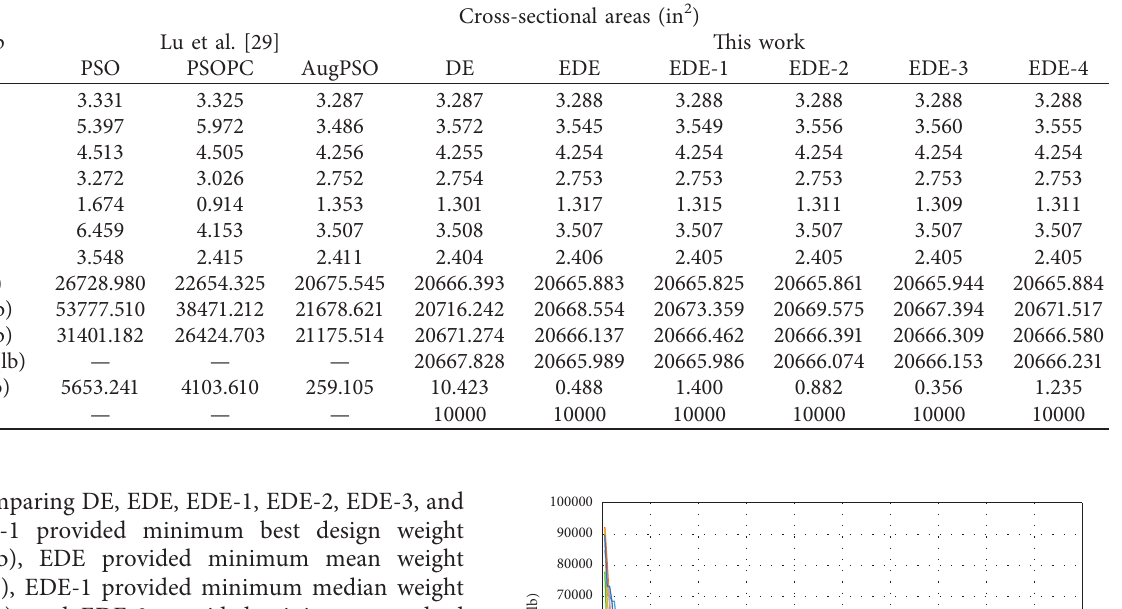
Table 7: Performance comparison of the 120-bar truss.